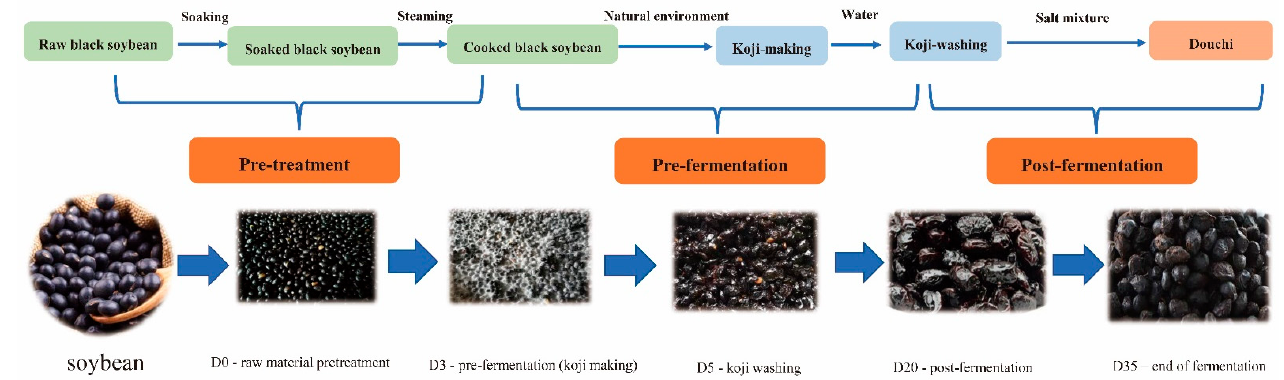
Figure 1. Sample diagram of Douchi in different fermentation stages.